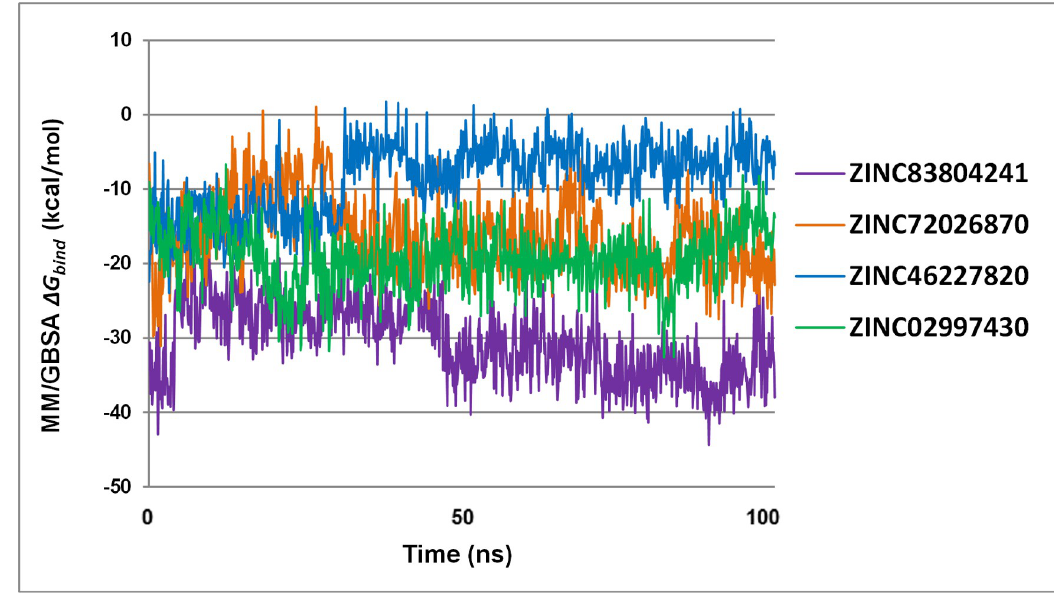
Fig 7. Total energy binding value for the 100 ns MD simulation of 4 top hit ligands. Including ZINC02997430 (in green), ZINC83804241 (in purple), ZINC72026870 (in orange) and ZINC46227820 (in blue) as per calculated using the MMGBSA method.